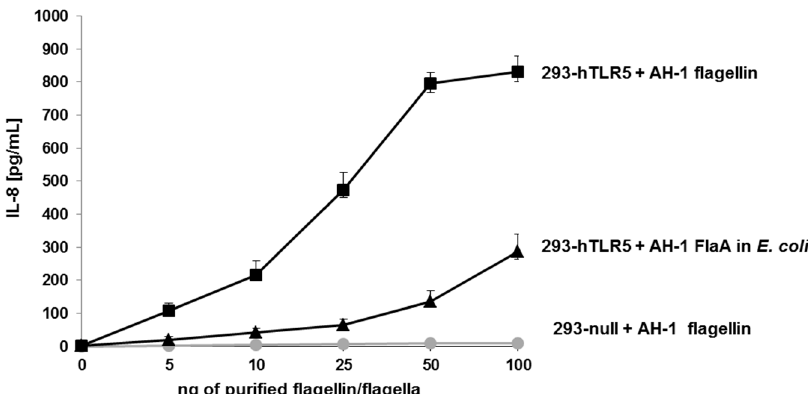
Figure 7. IL-8 production of HEK293-null and HEK293-hTLR5 cells. HEK293-null and HEK293-hTLR5 IL-8 production of HEK293-null and HEK293-hTLR5 cells. HEK293-null cells were stimulated with five different increased amounts (from 5 to 100 ng) of purified polar flagella from A. hydrophila AH-1 (wild-type) strain. HEK293-hTLR5 cells were also stimulated with A. hydrophila AH-1 polar flagellin FlaB obtained in E. coli (non-glycosylated). Data shown are means ± SD of three independent experiments.